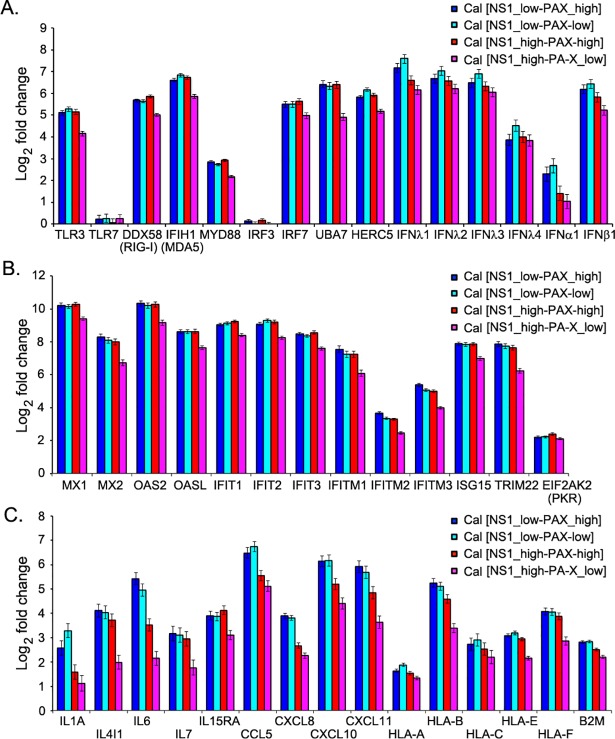
Induction of representative genes in infected cells.Fold change of genes involved in (A) innate signaling and IFNs, (B) ISGs, and (C) cytokines, chemokines and MHC class I molecules are shown. Bar graphs demonstrate fold change of the host genes in response to the virus infection compared to mock as revealed by the RNA-Seq analysis.